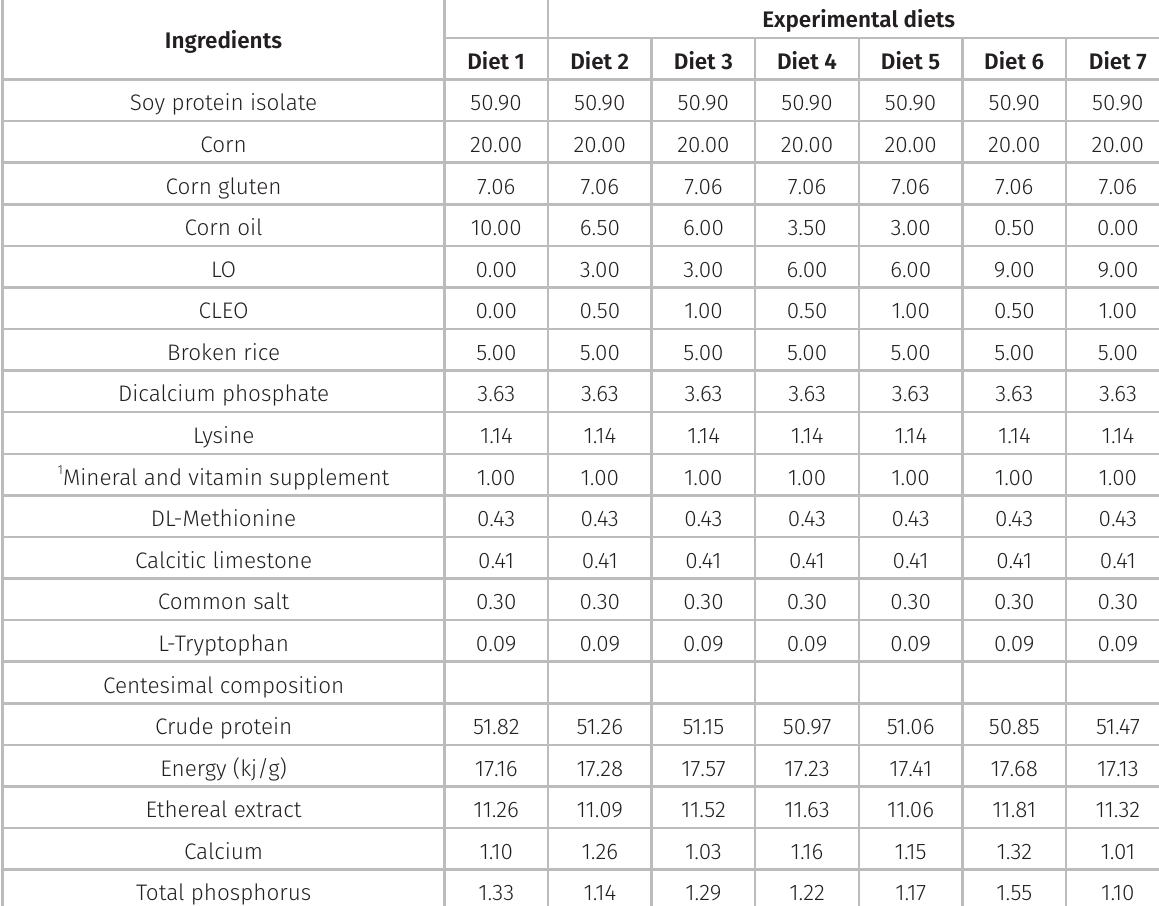
Table I. Percentage composition of the experimental